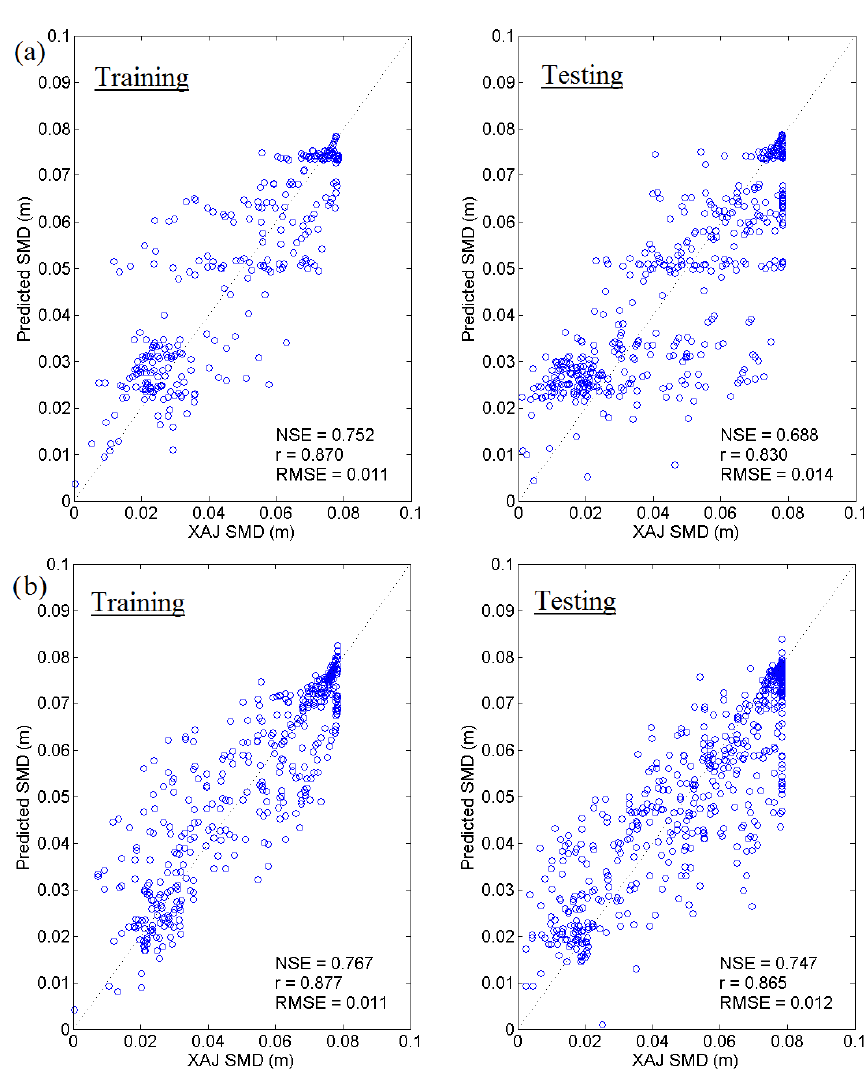
Figure 6. LLR modelling during the training and testing phases for (a) scheme 1 and (b) scheme